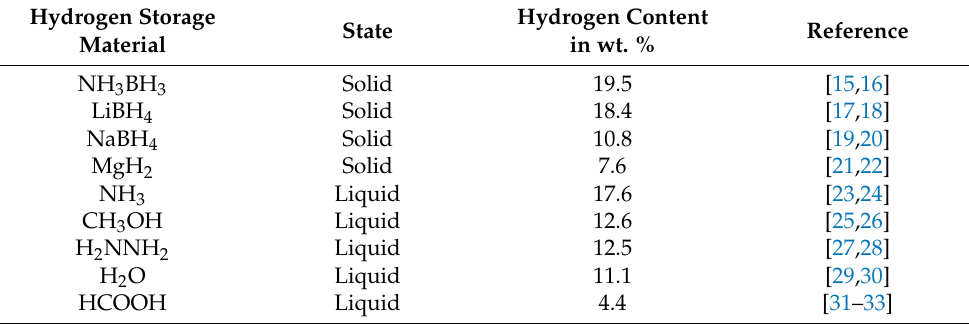
Table 1. Examples of hydrogen storage molecules. Hydrogen